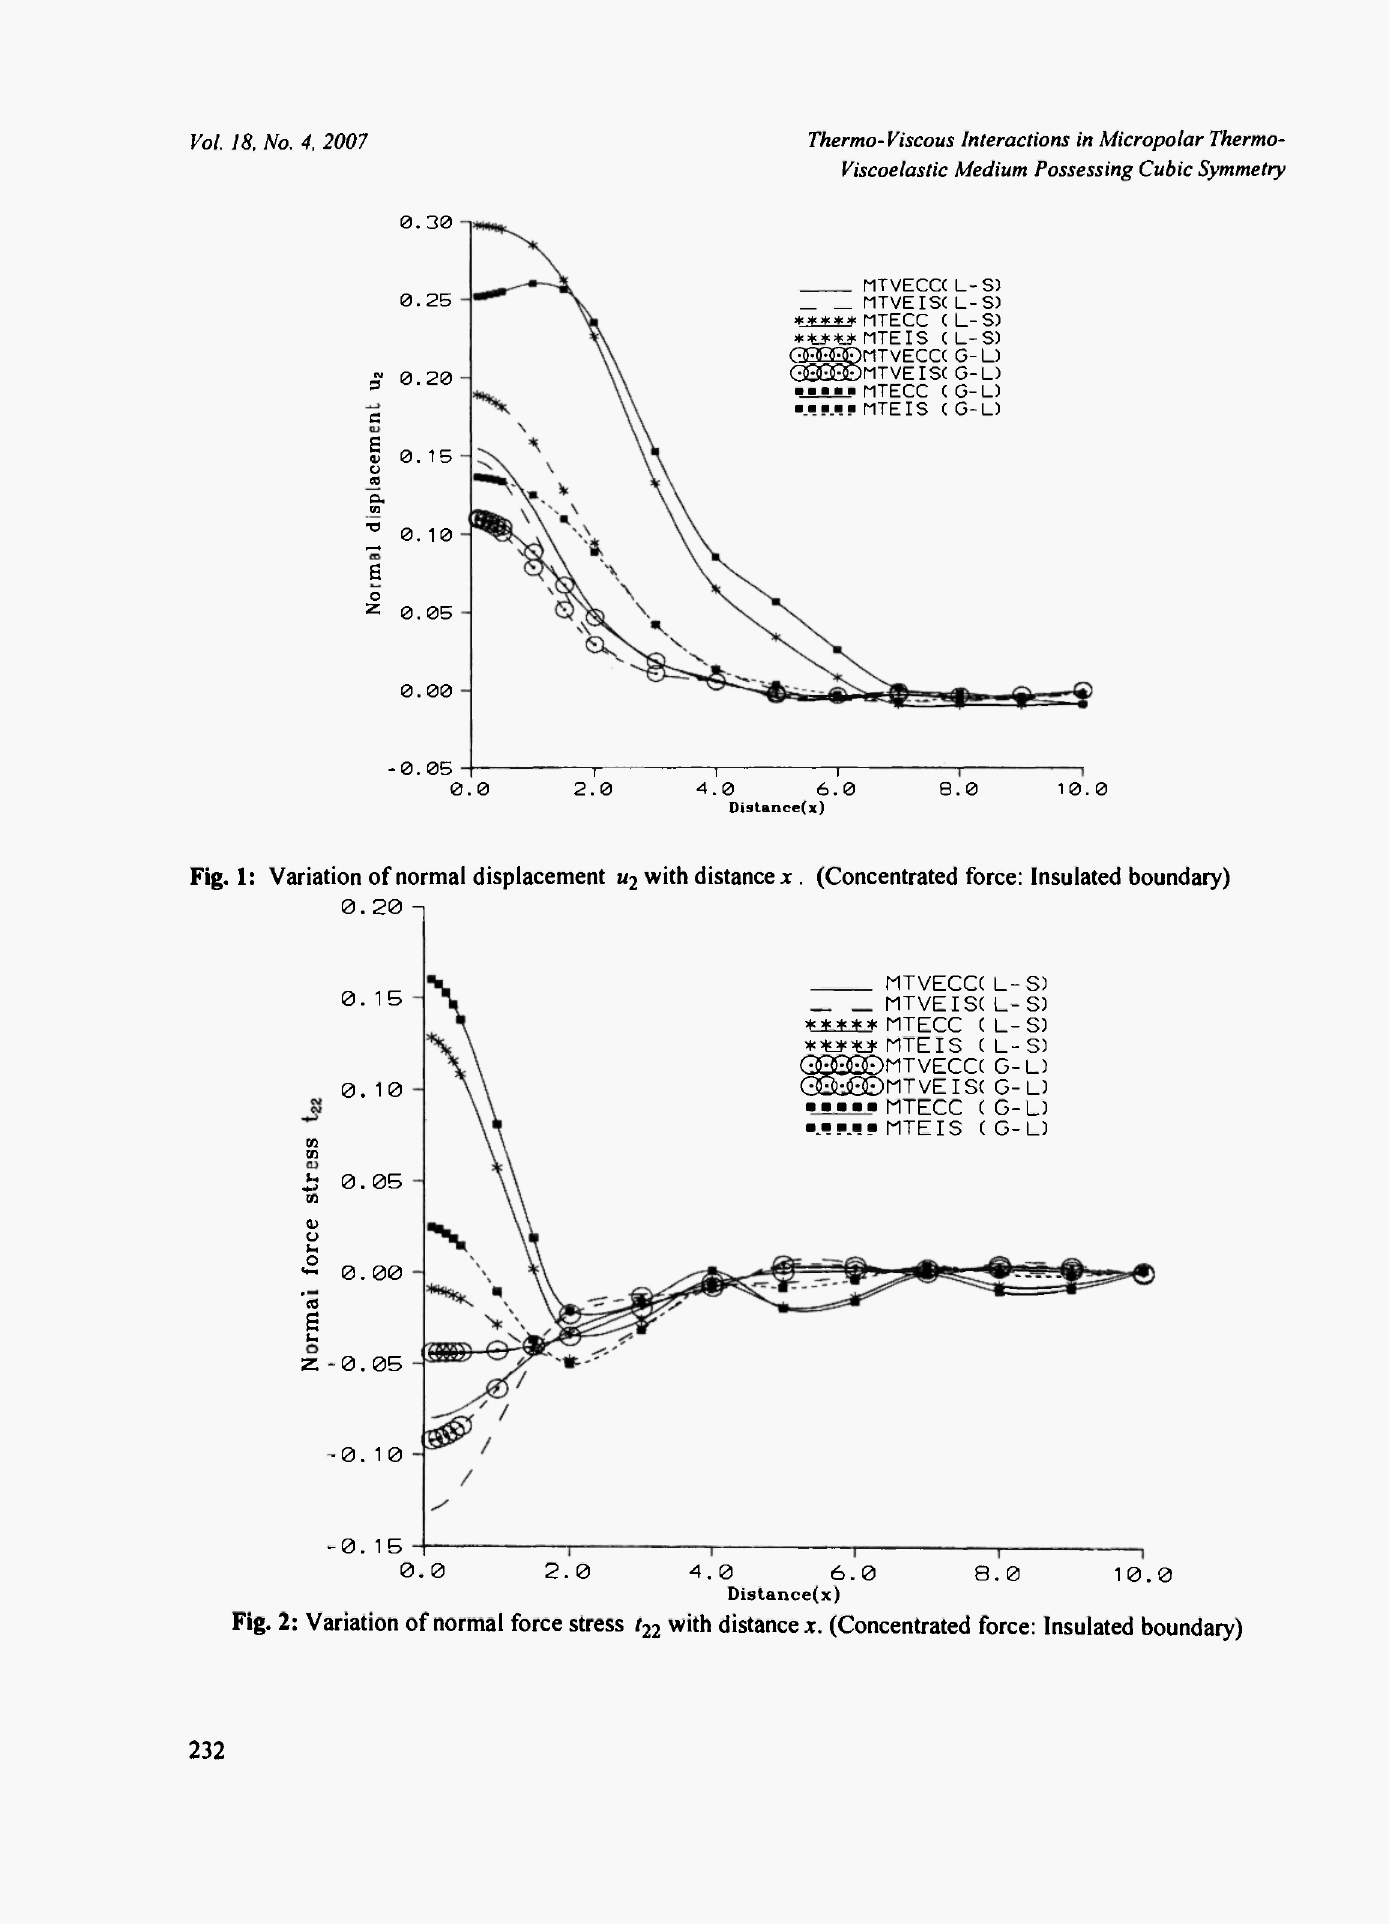
Fig. 2: Variation of normal force stress t 22 with distances. (Concentrated force: Insulated